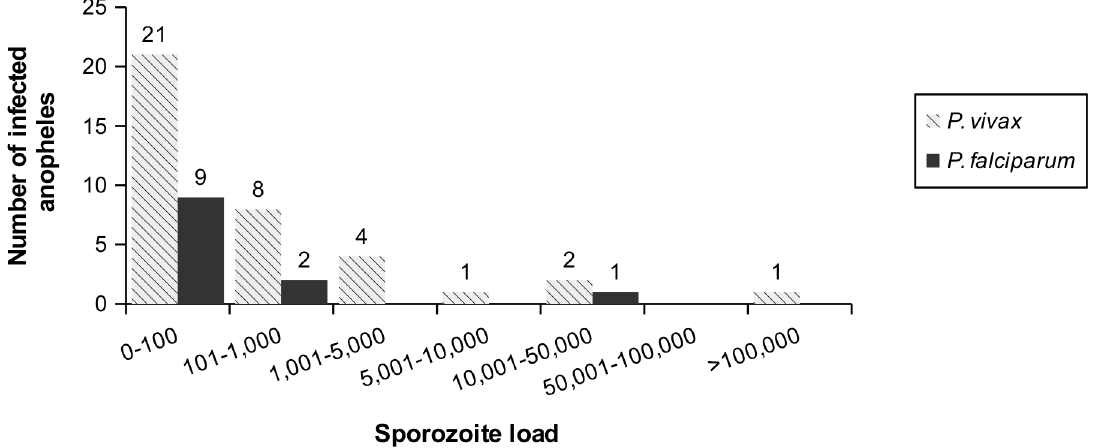
Fig 2. Frequency distribution of the sporozoite loads in naturally infected Anopheles collected along the Thai- Myanmar border. The sporozoite loads in the studied area are very low: 60% (30/49) of the infected Anopheles carry less than 100